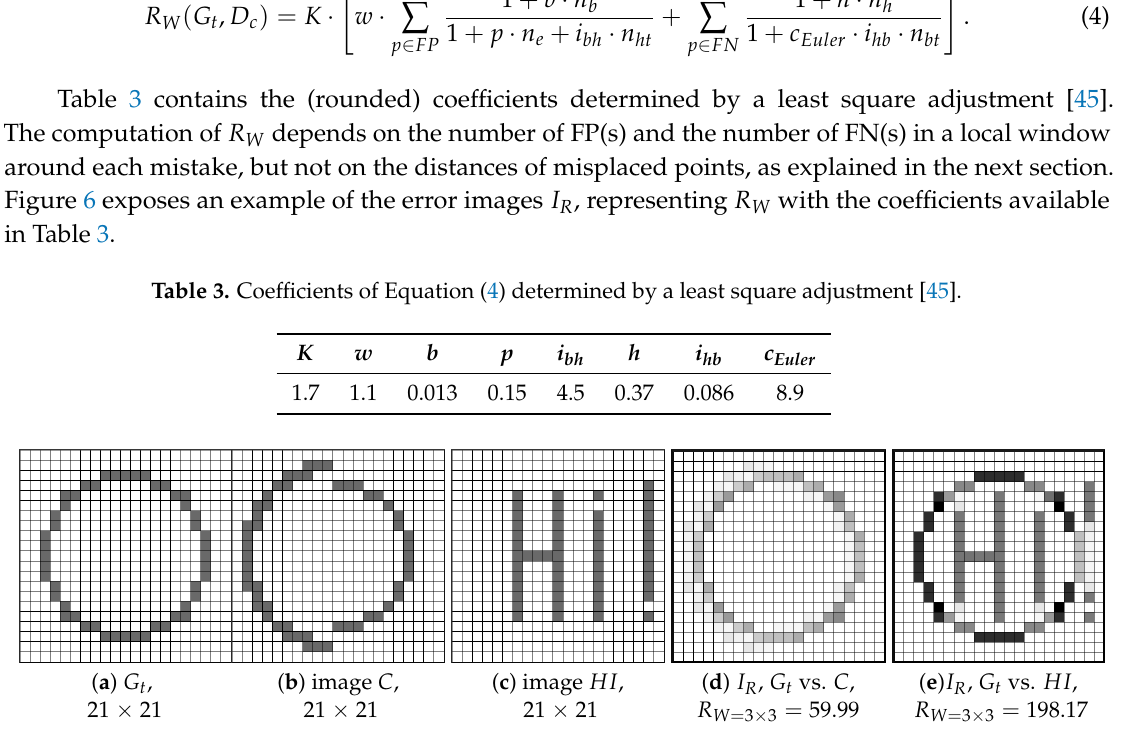
Figure 6. R evaluation depends on mistake distances but depends on an area contained in a window around a mistake point. I R corresponds to the value of R W for each pixel. Images representing I R in ( d , e ) correspond to inverse images. Here, the window size around each mistake is of size W = 3 ×